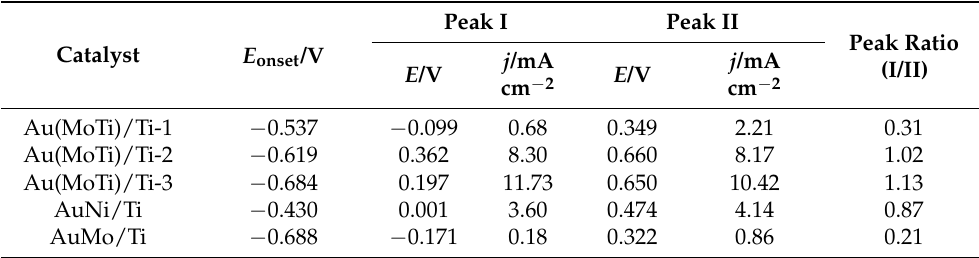
Table 2. Summary of electrochemical measurements (1st cycle of CV) at different catalysts in 0.1 M